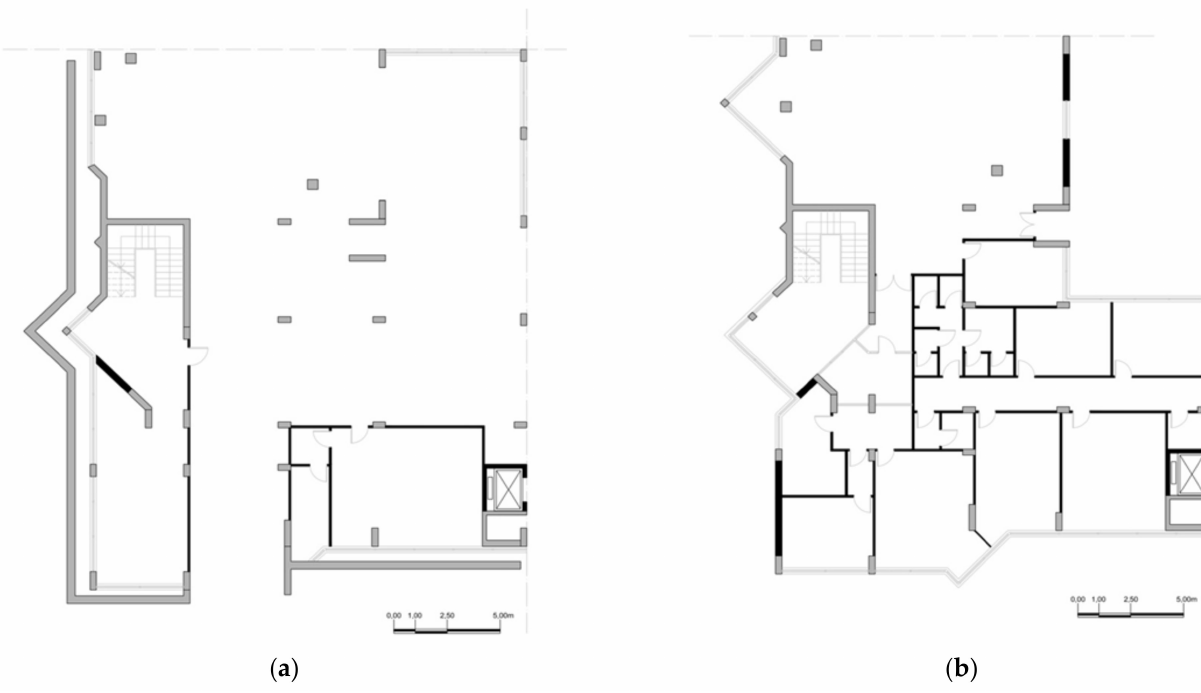
Figure 3. Building Plans: ( a ) Basement floor; ( b ) Raised